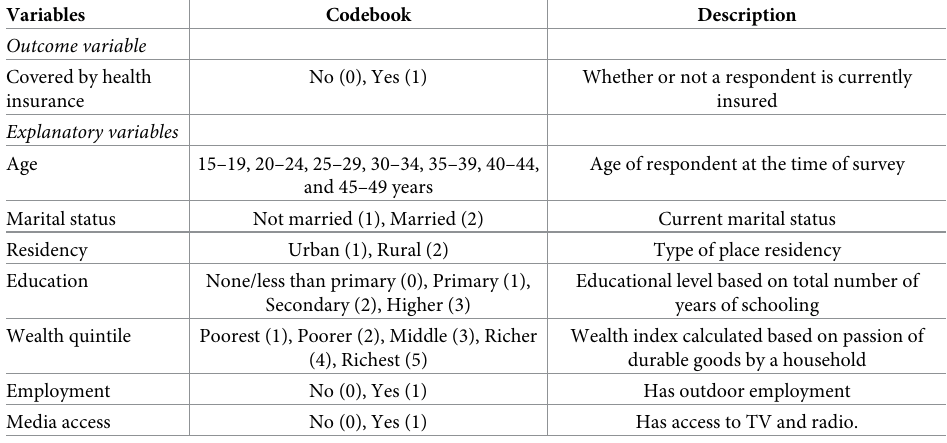
Table 1. Description of the variables included in the